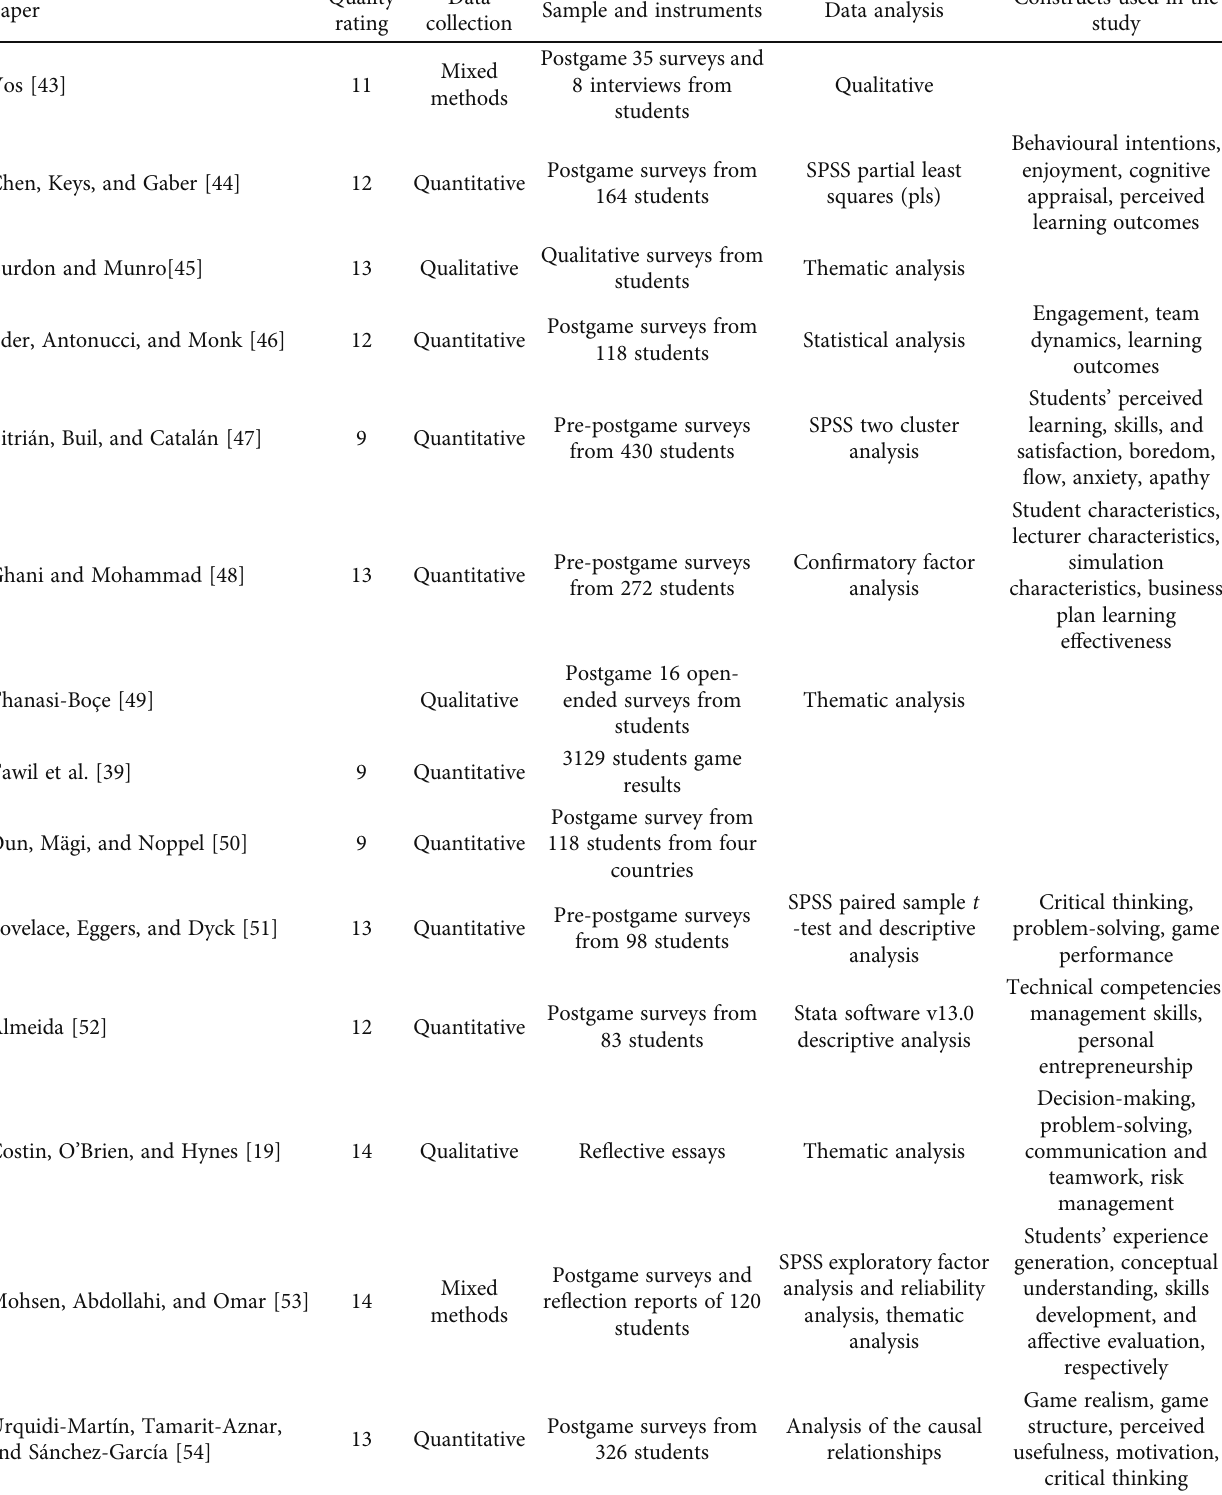
Table 5: Quality ratings and methodologies of selected